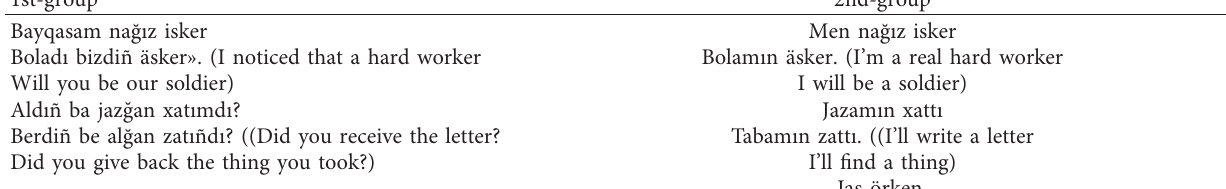
Table 2: Items are composed of two groups with given word pairs.